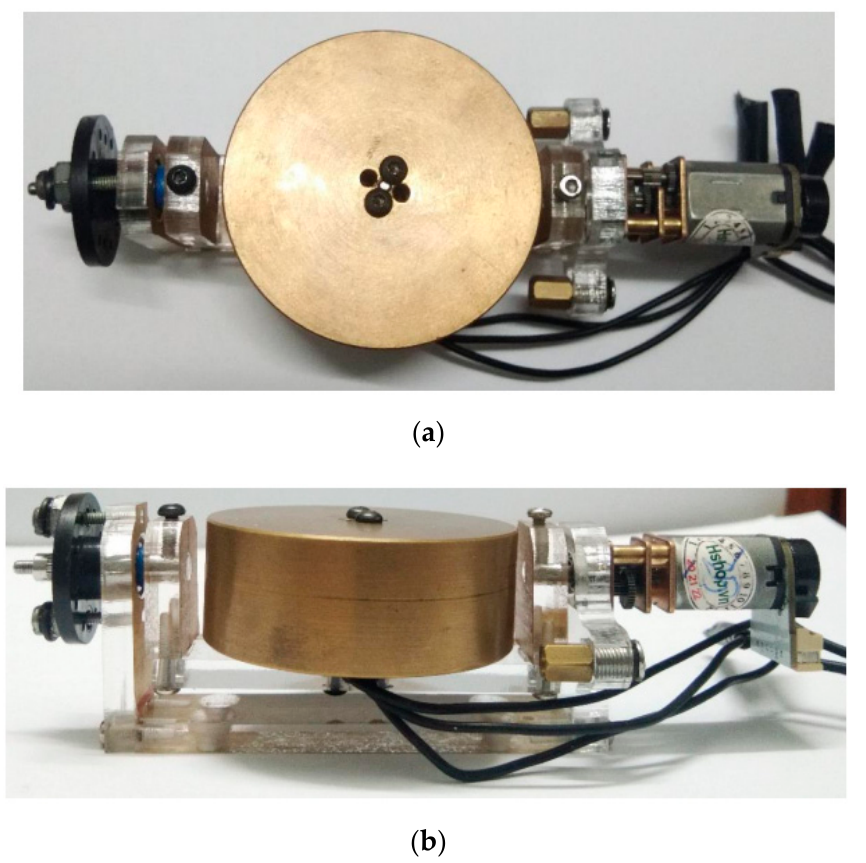
Figure 9. Real-world model of the proposed wearable device: ( a ) top view and ( b ) side view.